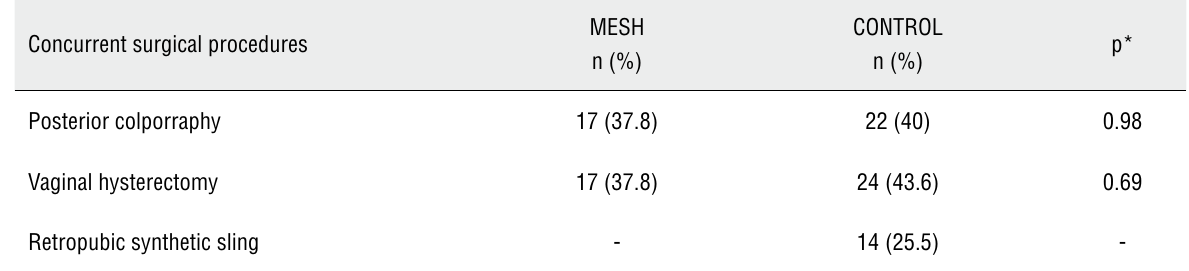
Table 5 - Concurrent surgical procedures in Mesh (n = 45) and Control (n = 55) groups. Values represent the number of patients according to the type of surgery in each group and respective